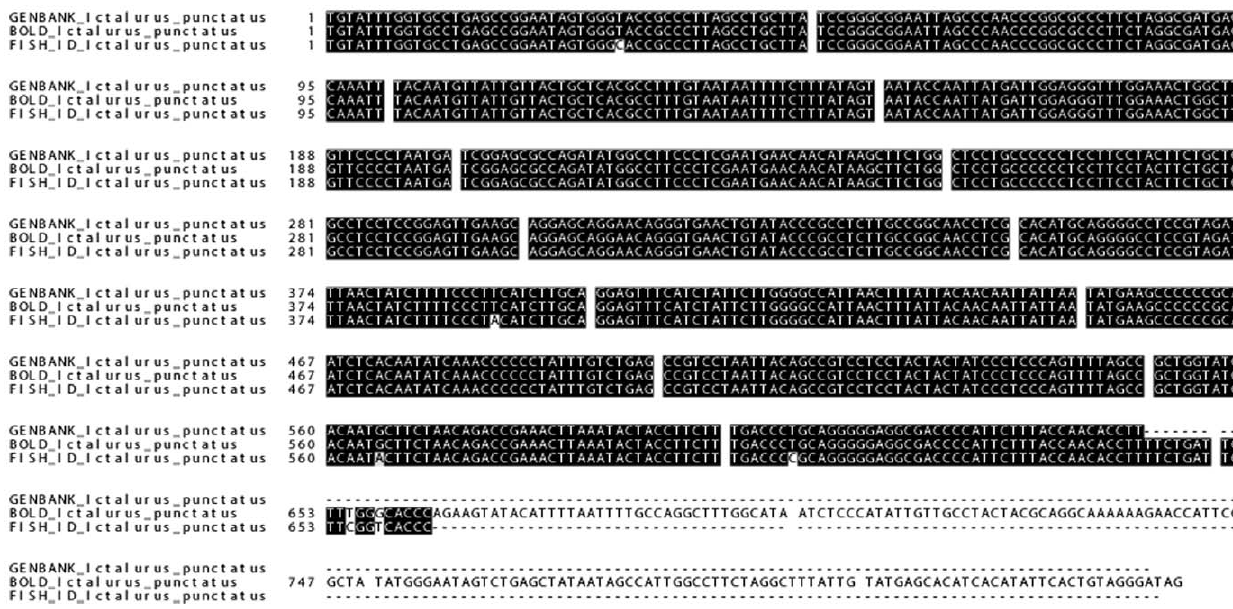
Figure 2. Multiple sequence alignment of consensus sequences for Ictaluruspunctatus against voucher and reference sequences from GenBank and BOLD databases. A multiple sequence alignment of Ictalurus punctatus was generated by ClustalW and graphically represented by BOXSHADE 3.21. The nomenclature of the aligned sequences is as follows: FISH_ID_Ictalurus_punctatus (as I. punctatus consensus sequence in the present study), GENBANK_Ictalurus_punctatus (as GenBank voucher species consensus sequence) and BOLD_Ictalurus_punctatus (as BOLD species reference consensus sequence). Both voucher and reference sequences were downloaded from the two databases with the accession numbers listed in Table S2. Highly conserved regions which were $ 50% identical were boxed in solid black and light shading indicates conservative substitutions.